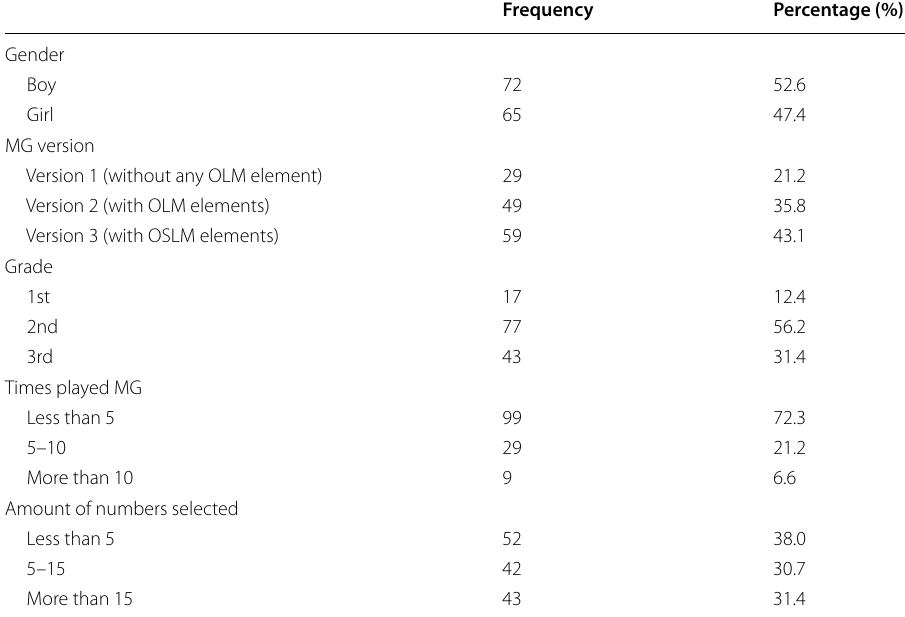
Table 2 Factors and Questionnaire items Factor Questionnaire Item (see appendix for the pupil